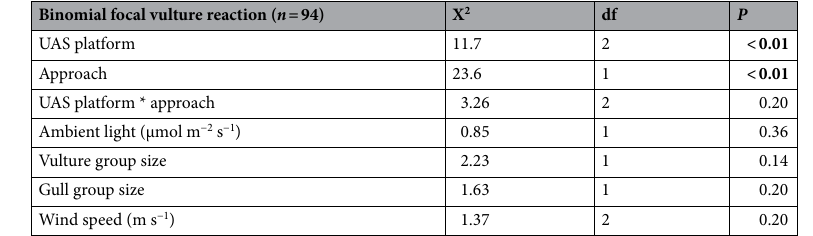
Table 1. Results from the generalized linear model analysis using a binomial distribution of turkey vulture reactions in response to UAS approach. For UAS platform, the categories were fixed-wing, multirotor, and ornithopter and approach included targeted or overhead. Trials were conducted at the Erie County Landfill, Ohio, between July and September 2019. Significant results are marked in bold.